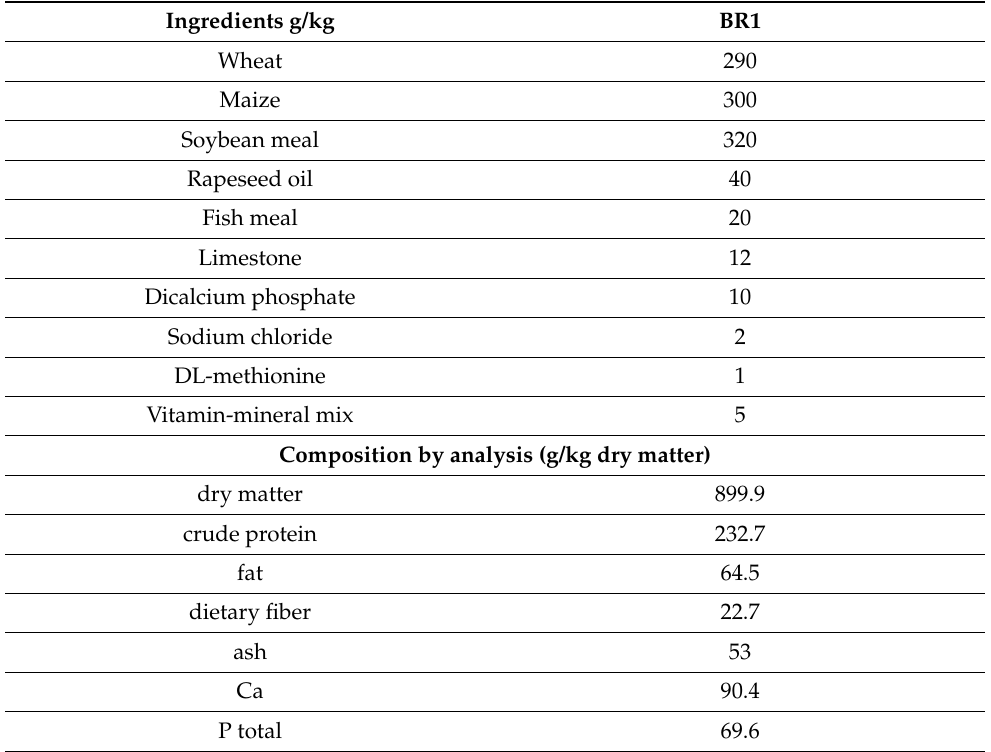
Table 1. Composition of commercial diet